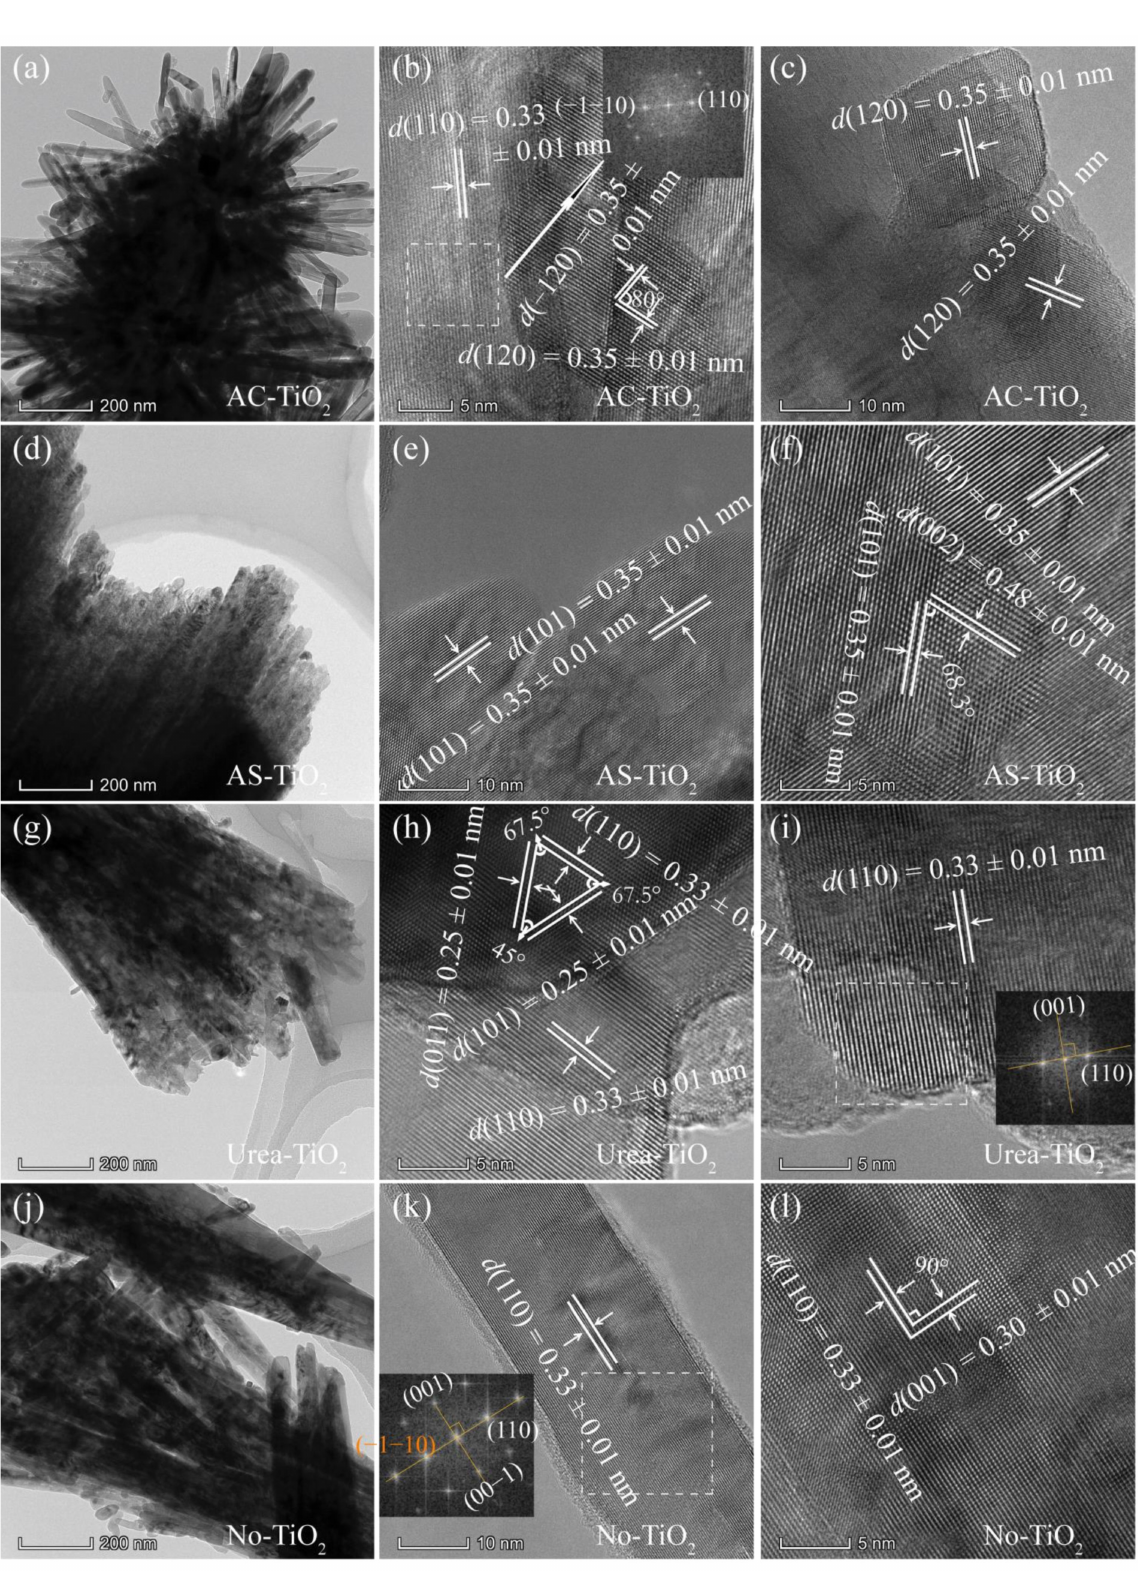
Figure 3. TEM and HRTEM images of the prepared ( a – c ) AC-TiO 2 ; ( d – f ) AS-TiO 2 ; ( g – i ) urea- TiO 2 ; ( j – l ) No-TiO 2 samples in the presence and absence of shape-controlling agents. The insets in ( b , i , k ) are fast Fourier transform (FFT) diffraction